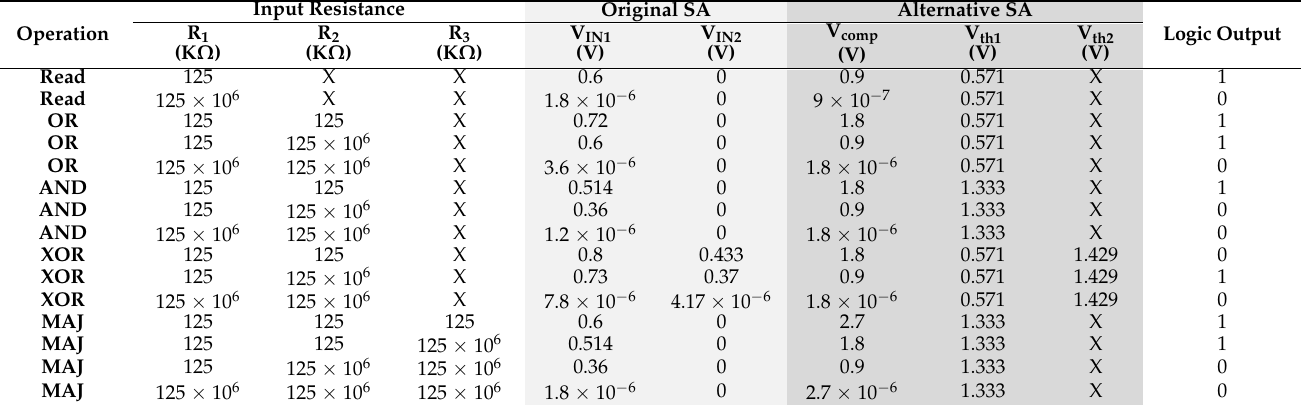
Table 1. Calculated voltages at nodes of interest of the SA modules for all possible